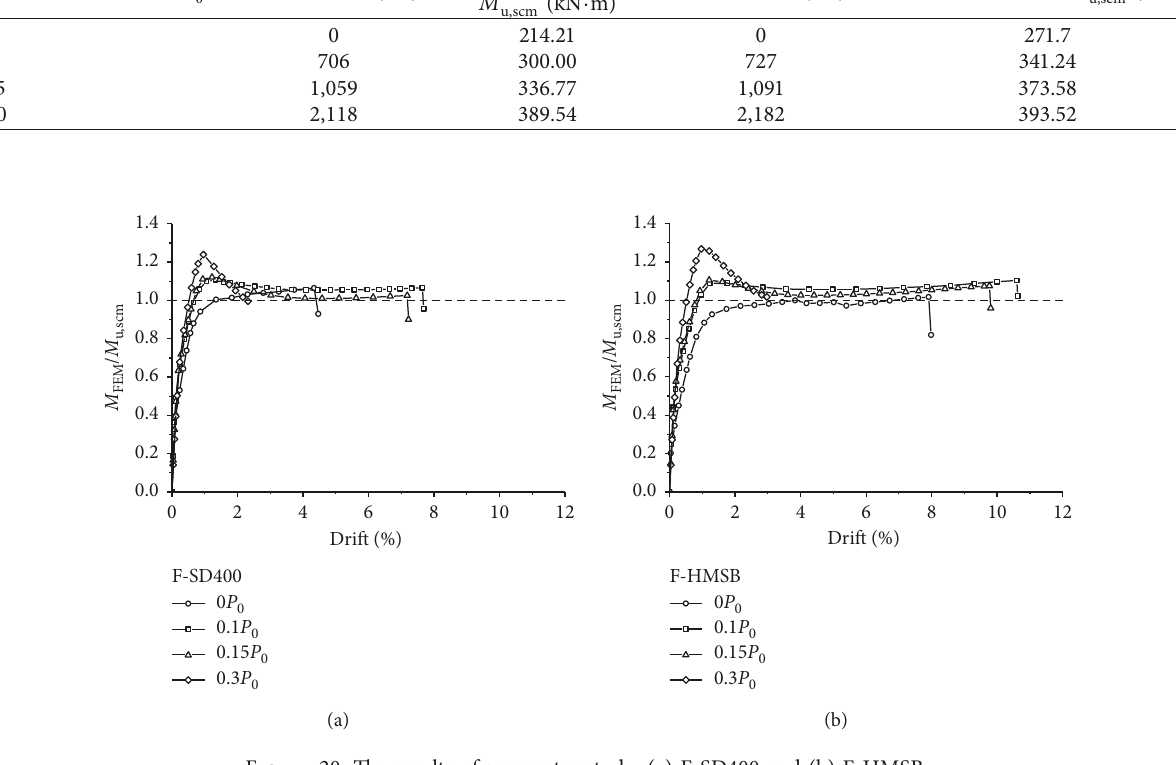
Figure 20: The results of parameter study: (a) F-SD400 and (b) F-HMSB.